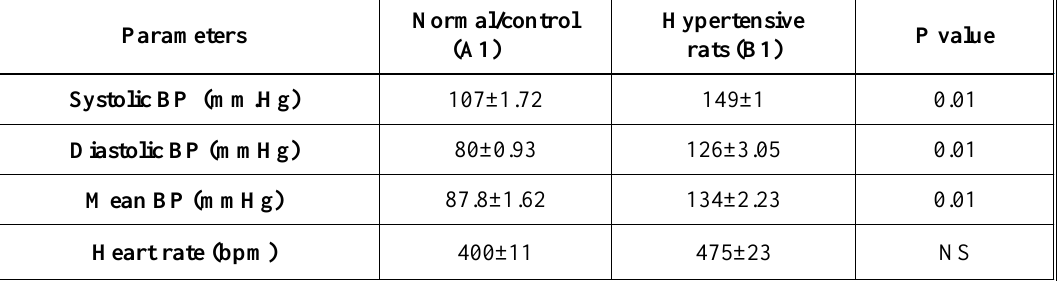
Table 4. Comparison between blood pressure parameters in normal and hypertension group after fructose 10 % provision for 3